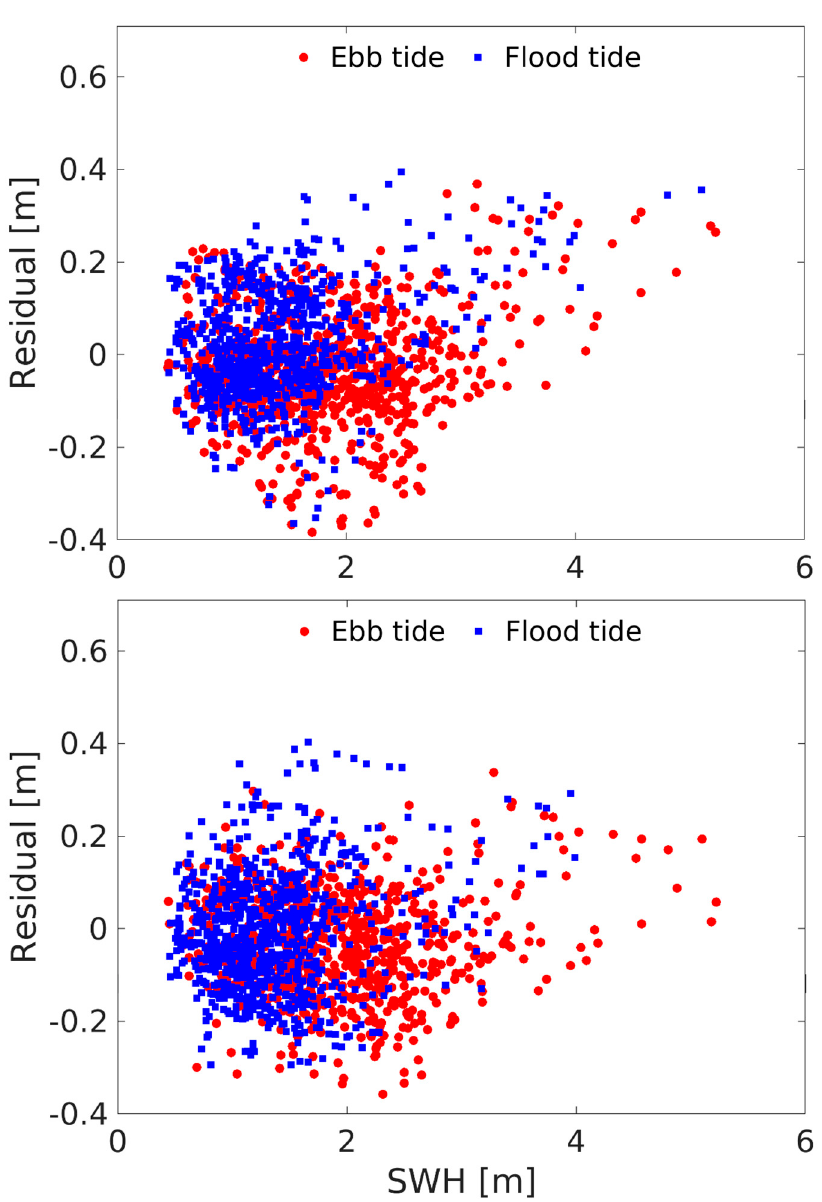
Figure A2. A relationship between tidal residuals and SWHs (February to April 2012) at Point Lonsdale based on both measured and modelled data. The top panel plots the field data while the bottom panel plots the modelled results (SCHISM/WMMIII). The measured tidal residuals were extracted from tidal gauges while the measured SWHs were extracted from bottom-mounted sensors (AWAC).